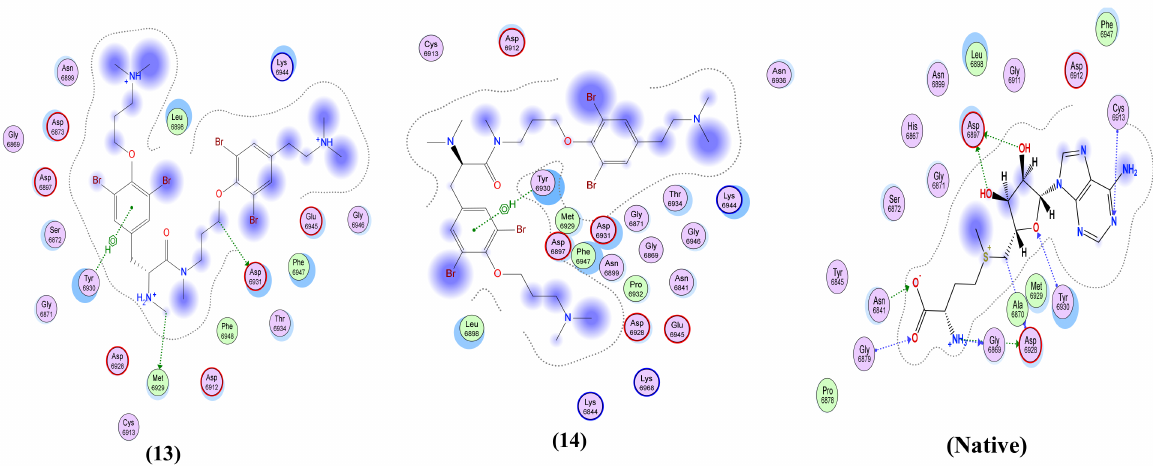
Figure 8. The 2D interactions of the 14 test compounds and the native ligand with the non-structural protein, nsp10 (PDB ID: 6W4H).